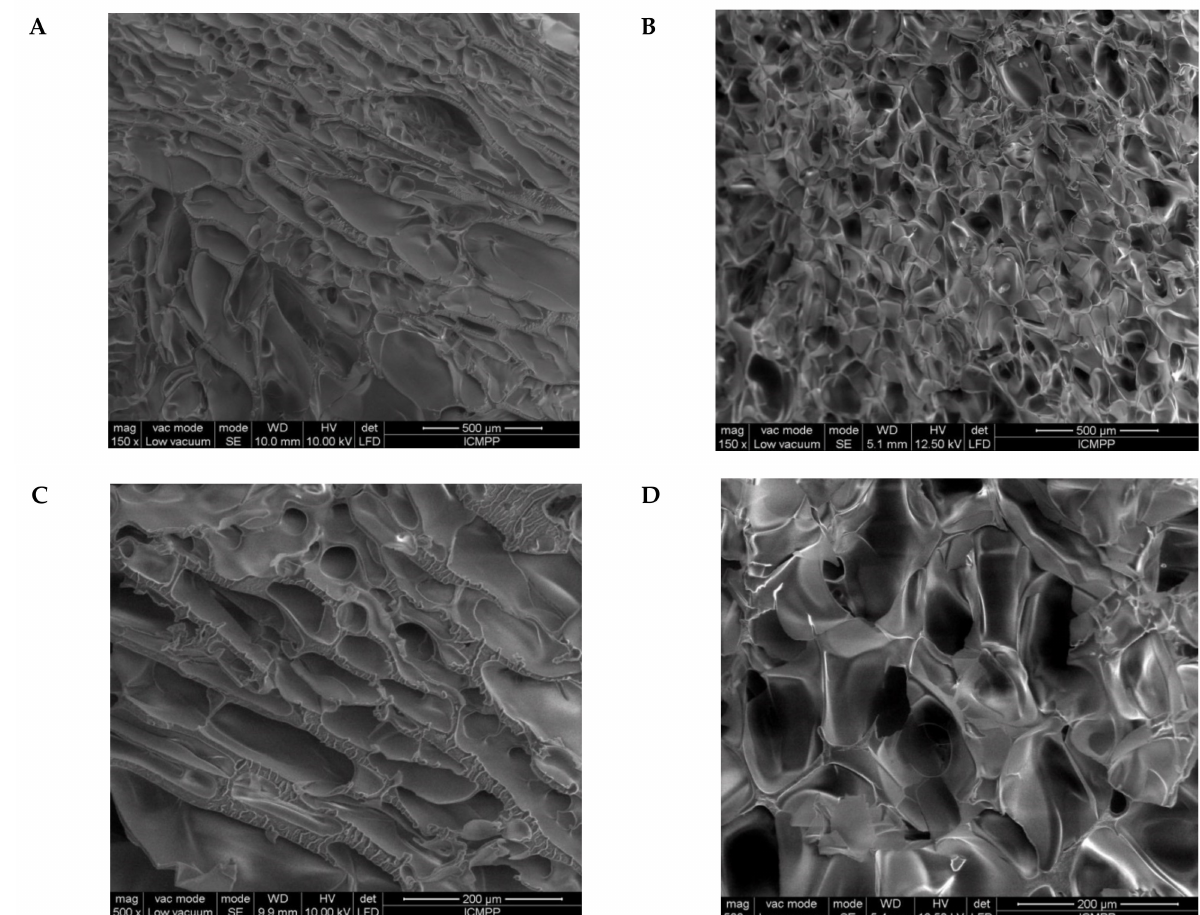
Figure 5. SEM images of the s-IPN50 before ( A , C ) and after ( B , D ) the reaction with MCT- β -CD, at a magnification of 150 × ( A , B ) and 500 × ( C , D